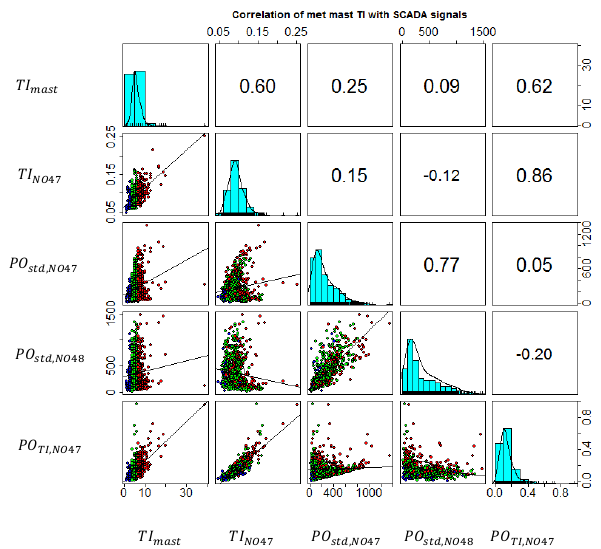
𝑃𝑂 𝑚𝑚𝑠 , 𝑁𝑂47 𝑃𝑂 𝑚𝑚𝑠 , 𝑁𝑂48 𝑃𝑂 𝑊𝑇 , 𝑁𝑂47 Figure 12. Correlation analysis for Nordsee Ost. Turbulence inten- sity (TI mast ) measured at hub height is correlated with the TI mea- sured with the nacelle anemometer of NO47 (TI NO47 ), the rotor- estimated wind speed (TI NO47 ), the standard deviation of the ues 10min power of NO47 (PO std , NO47 ), the standard deviation of the 10min power of NO48 (PO std , NO48 ) and the standard deviation of the power divided by the average power of NO47 (PO TI , NO47 ). All dimensions are in % except for the standard deviation of the power, which is in kW.